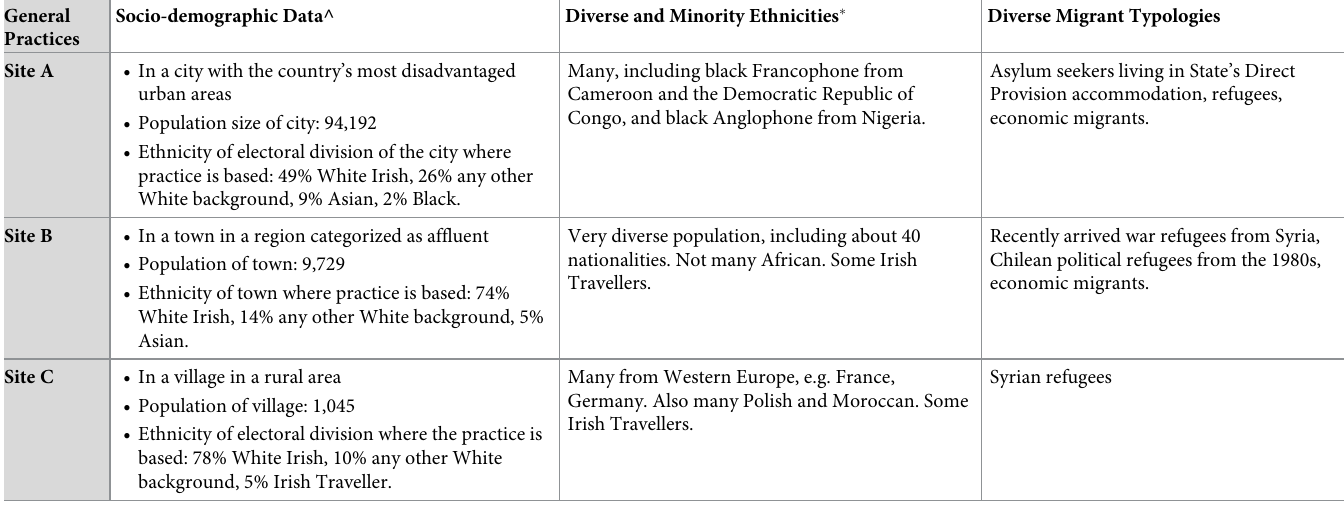
Table 2. Description of case study